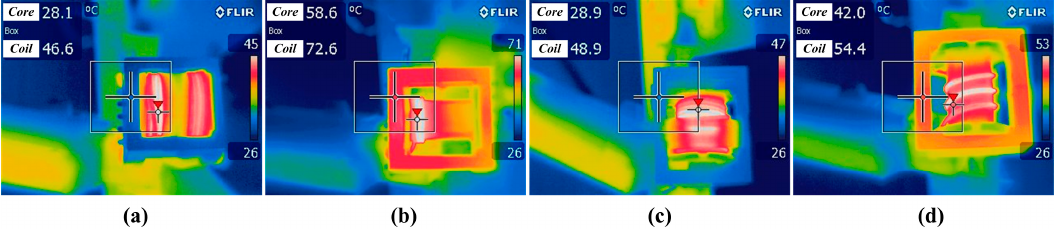
Figure 16. Thermal camera images of inductors: ( a ) 1:1 transformer at P b = 500 W, ( b ) inductor 1 at P b